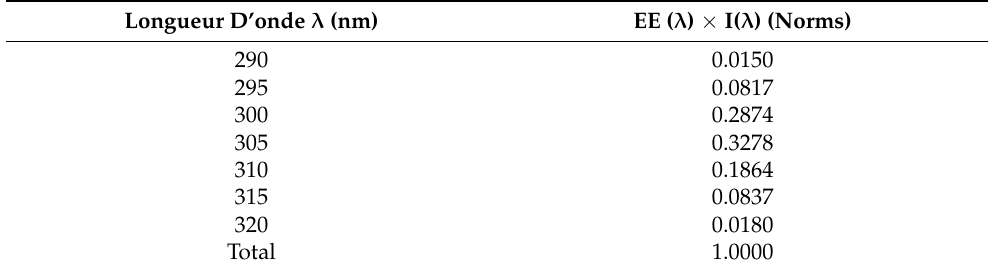
Table 1. The normalized product function used in the calculation of sun protection factor (SPF). Longueur D’onde λ